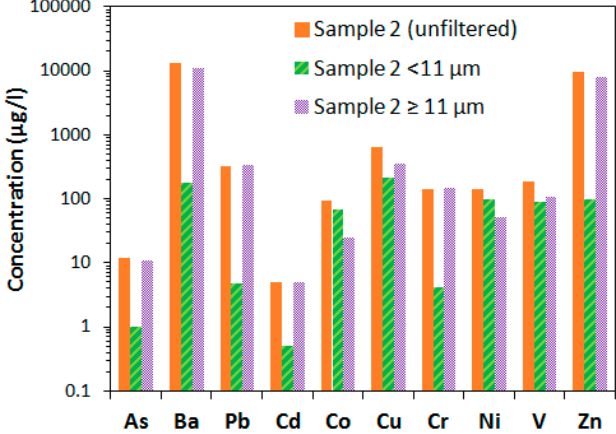
Figure 4. Concentration of metals in filtered and unfiltered samples at location 2.